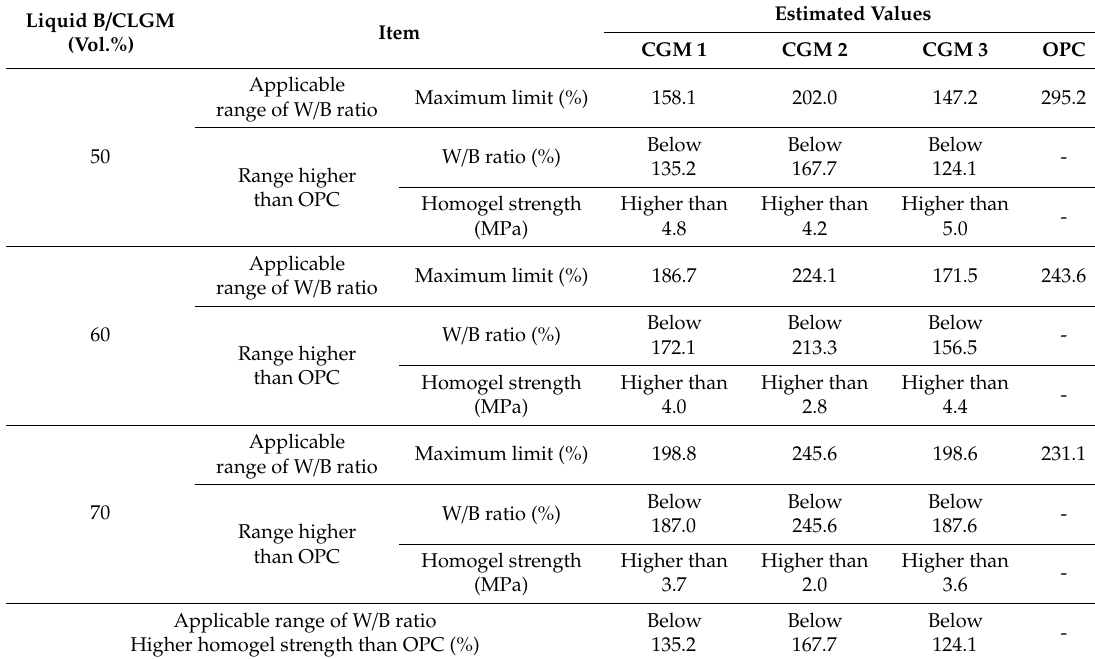
Table 7. Estimated values of homogel strength according to W / B ratio (seven